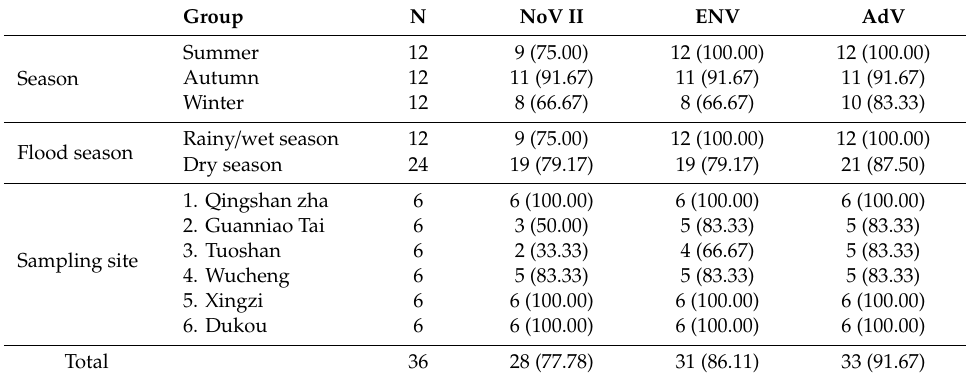
Table8. Detectionofentericvirusesamongdi ff